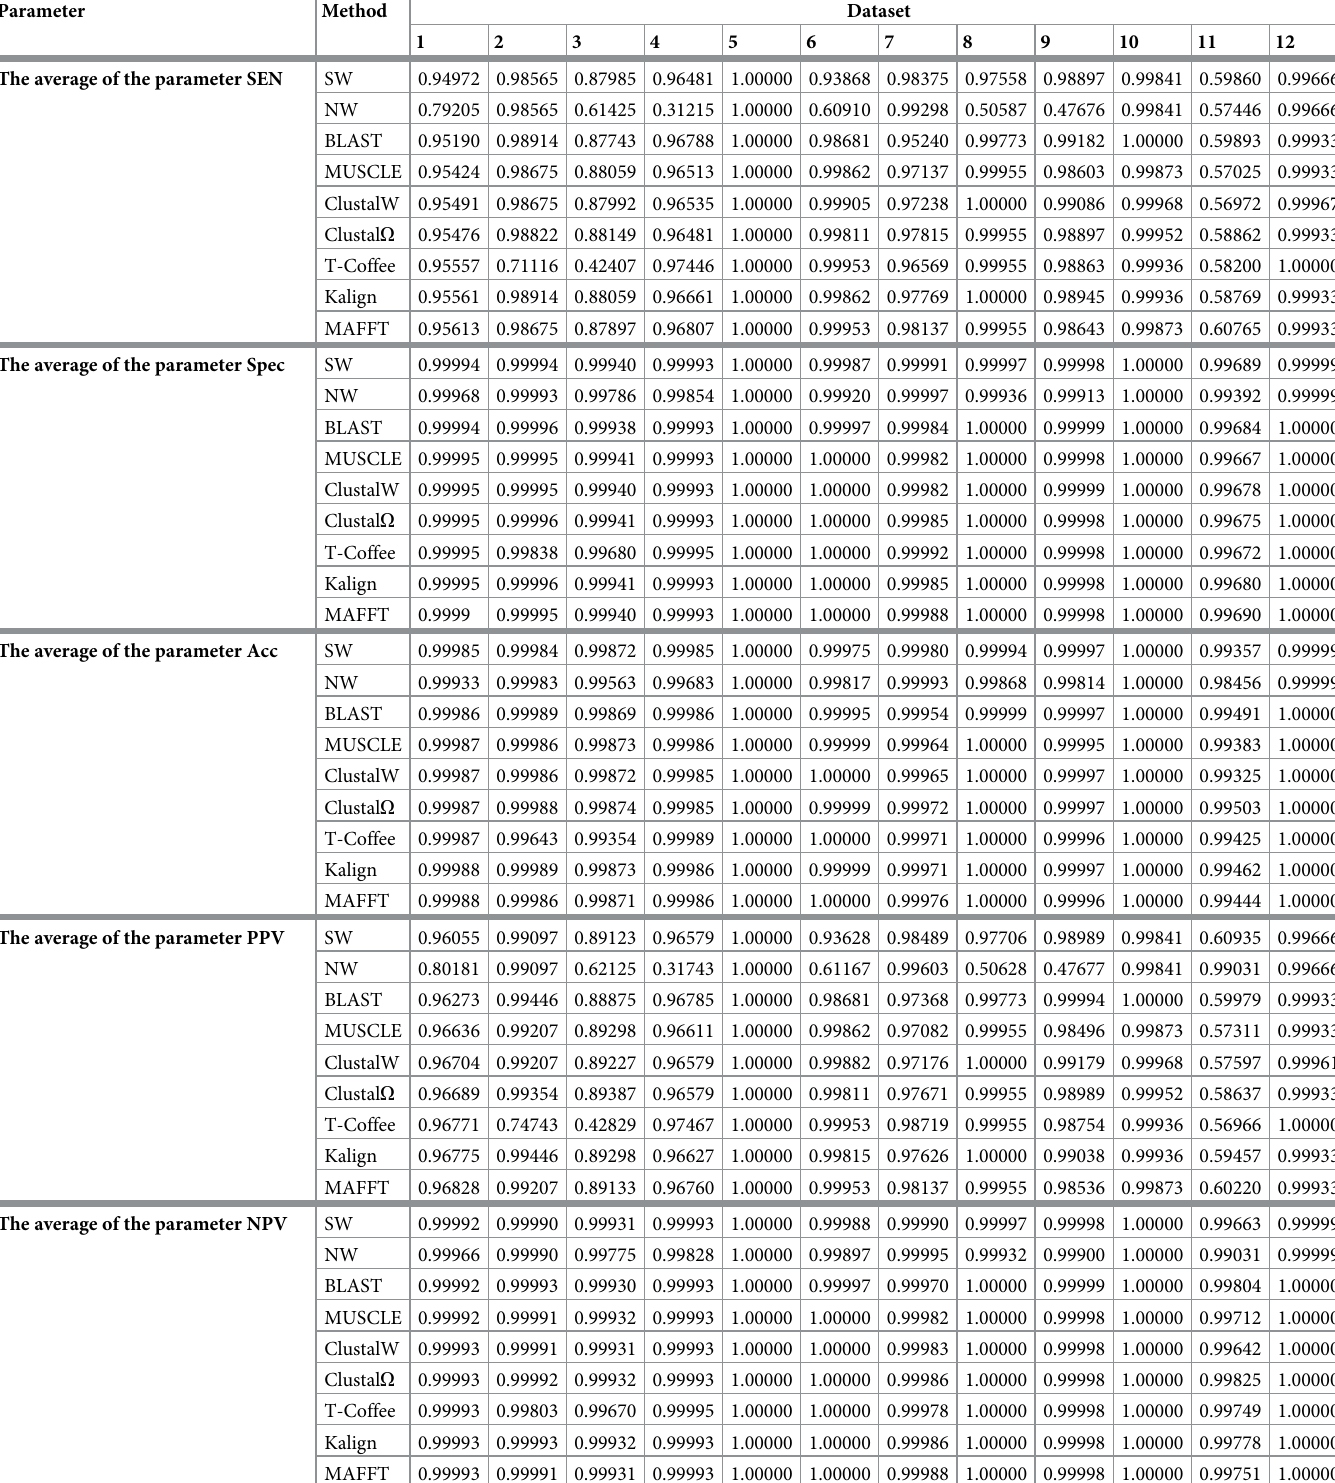
Table 15. A brief report of the accuracy measurement of classification output of the HELIOS method with referencing well-known algorithms, including Smith- Waterman, Needleman-Wunsch, ClustalW, Clustal O , BLAST, Muscle T-Coffee, Kalign, MAFFT algorithms. The parameters SEN, Spec, ACC, PPV, NPV, MCC, and F-Score are averaged and reported. The twelve datasets [53, 55–61] are